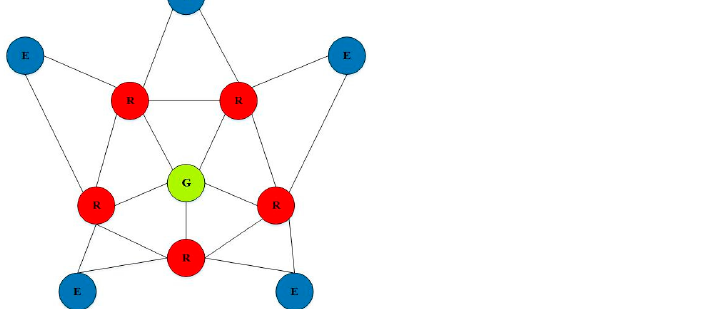
Figure 4. Star topology structure [24].